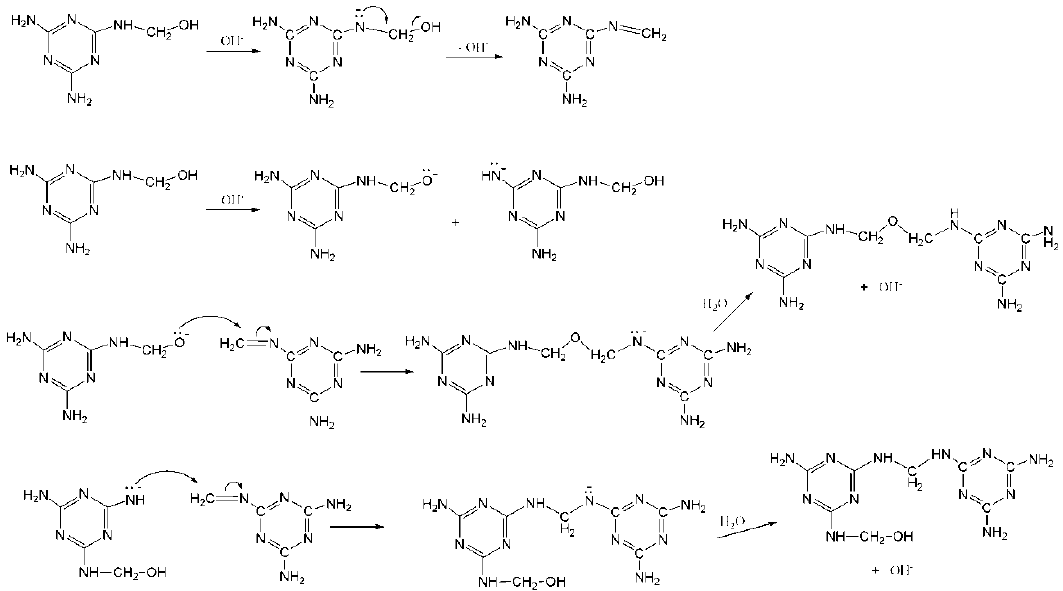
Figure 5. The proposed mechanism for base-catalyzed melamine-formaldehyde condensation reactions.